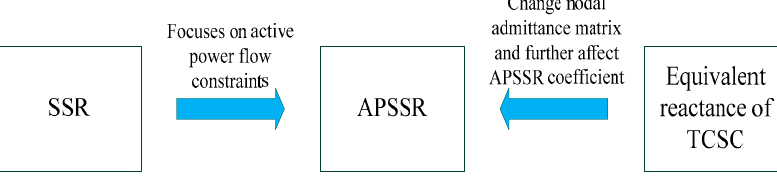
Figure 1. Relationships among steady-state security region (SSR), active power steady-state security region (APSSR), and thyristor-controlled series compensator (TCSC).